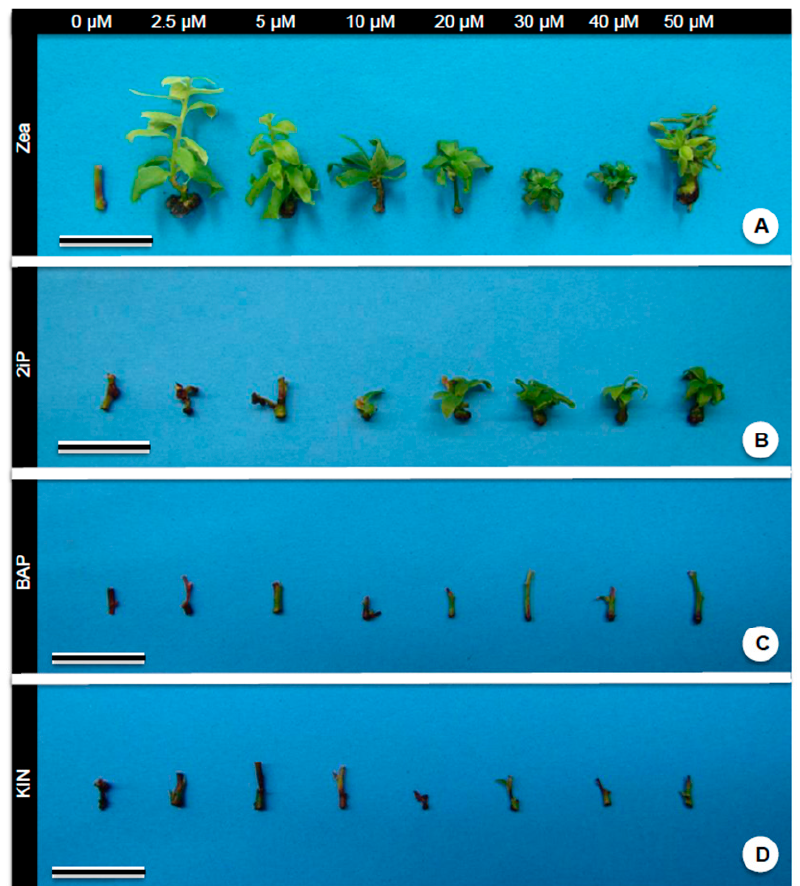
Figure 1. Initial in vitro shoot culture of ‘Delite’ rabbiteye blueberry in eight different concentrations (0, 2.5, 10, 20, 30, 40, and 50 µ M) with four different cytokinins: ( a ) ZEA, ( b ) 2iP, ( c ) BAP, and ( d ) KIN. Bars represent 2 cm. Abbreviations: BAP, 6-benzylaminopurine; KIN, kinetin; ZEA, zeatin; 2iP, 6-( γ - γ -dimethylallylamino)-purine.